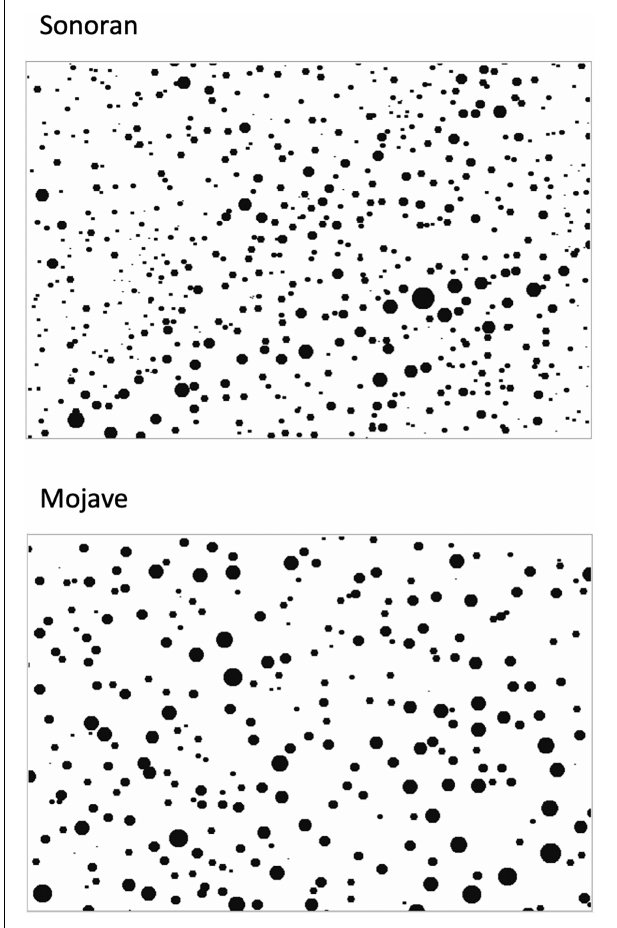
FIGURE 2 | Creosote maps used in the simulation program for the Sonoran and Mojave experimental plots based on field surveys. Both sites are 120 × 80 m, length vs. height